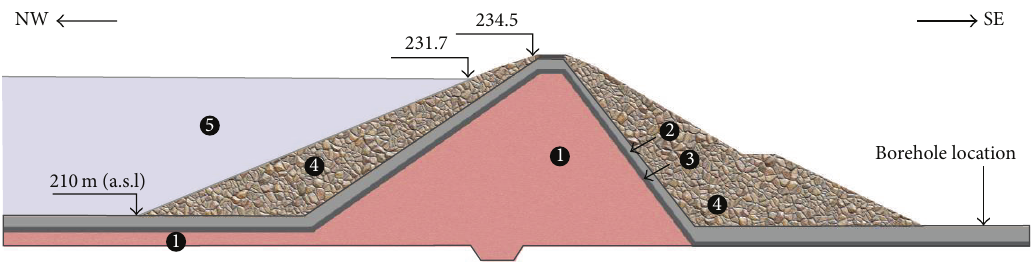
Figure 2: Cross-section in Abu Baara earth dam body, with (1) clay core, (2 and 3) filters, (4) support rockfill, and (5) water reservoir.